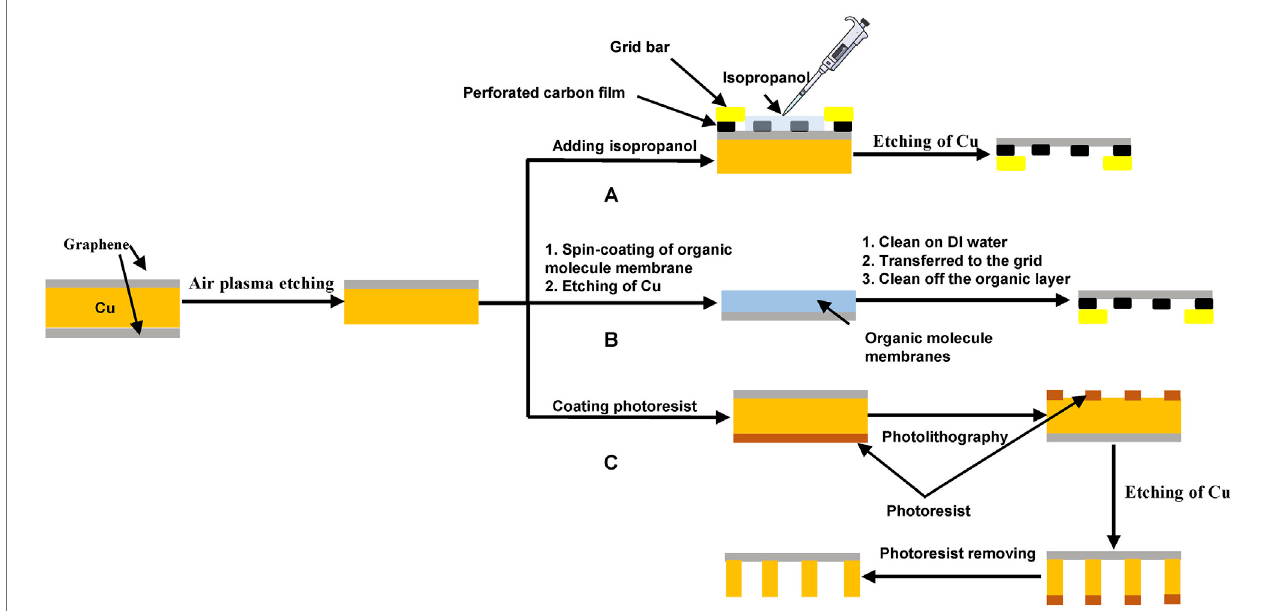
FIGURE 3 | Fabrication of graphene grids. (A) a transfer-free method for preparing graphene grids. This method uses isopropanol to adhere a perforated carbon fi lmontoagraphene fi lmandthenusesetchants,suchas(NH 4 ) 2 S 2 O 8 ,Na 2 S 2 O 8 ,andFeCl 3 (Ullahetal.,2021)toetchawaythecopper substrate (RussoandPassmore, 2014a;deMartinGarridoetal.,2021). (B) organicmolecule – assistedtransfermethodforpreparinggraphenegrids.Afterthemetalsubstrate,suchascopper,isetched, different organic membranes, such as PMMA (D ’ Imprima et al., 2019), MMA (Han et al., 2020), colloid polymer (Naydenova et al., 2019), and paraf fi n (Leong et al., 2019;Quet al., 2019),can be used to support thetransfer ofthe graphene fi lm tothe grid and then can be dissolved using organic solvents,such asacetone. (C) direct etching method for fabricating graphene grids. The photoresist is used to make a pattern on the metal substrate, which is then selectively etched to complete the fabrication of graphene grids (Zheng et al., 2020).